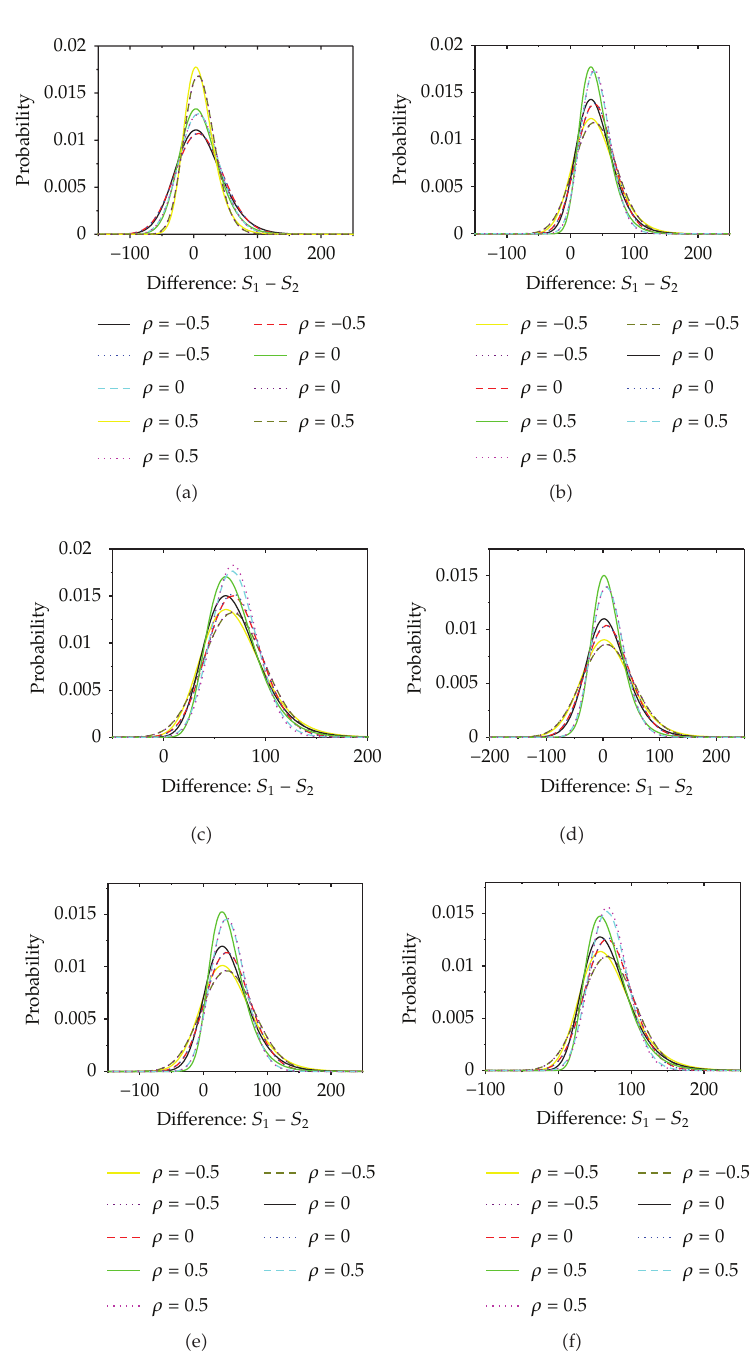
Figure 3: Probability density versus S 1 − S 2 : the dash lines denote the distributions of the approximate shifted lognormal process, the dotted lines indicate the distributions of the approximate shifted square- root process, and the solid lines show the exact results. (cid:3) a (cid:4) S 10 (cid:7) 110, S 20 (cid:7) 100, σ 1 (cid:7) 0 . 25, and σ 2 (cid:7) 0 . 15; (cid:3) b (cid:4)